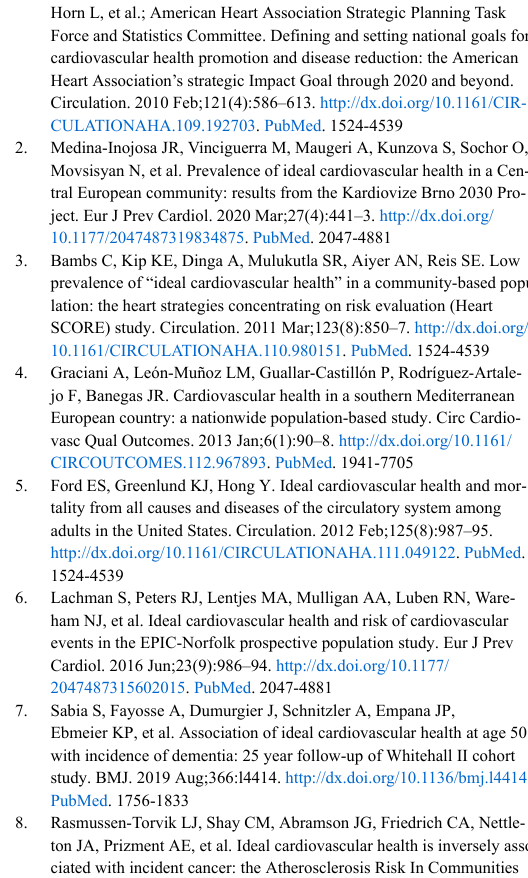
Table 3: Associations between baseline variables and the outcome of ideal cardiovascular health. Baseline variable